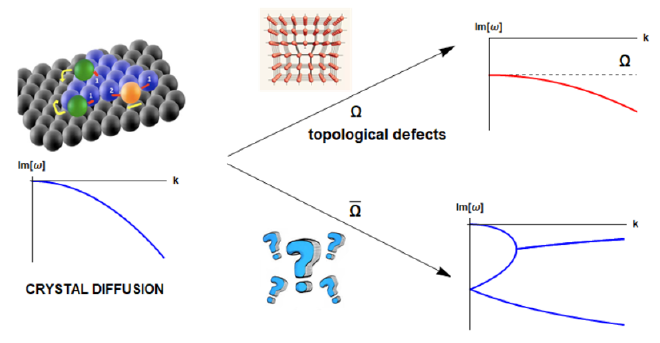
Figure 2 . The dynamics of crystal di(cid:11)usion in presence of phase relaxation. Phase relaxation mechanisms, (cid:10), induced by the proliferation of elastic defects, as dislocations, produce a damping term for the crystal di(cid:11)usion mode ! = (cid:0) i (cid:10) (cid:0) D (cid:30) k 2 . In the holographic models, the relaxation mechanism (cid:22)(cid:10) is proportional to the explicit breaking of translations and does induce a complicated dynamics between three di(cid:11)erent modes. In summary, the two mechanisms can not be simply thought as di(cid:11)erent contributions to the total phase relaxation (cid:10) rel